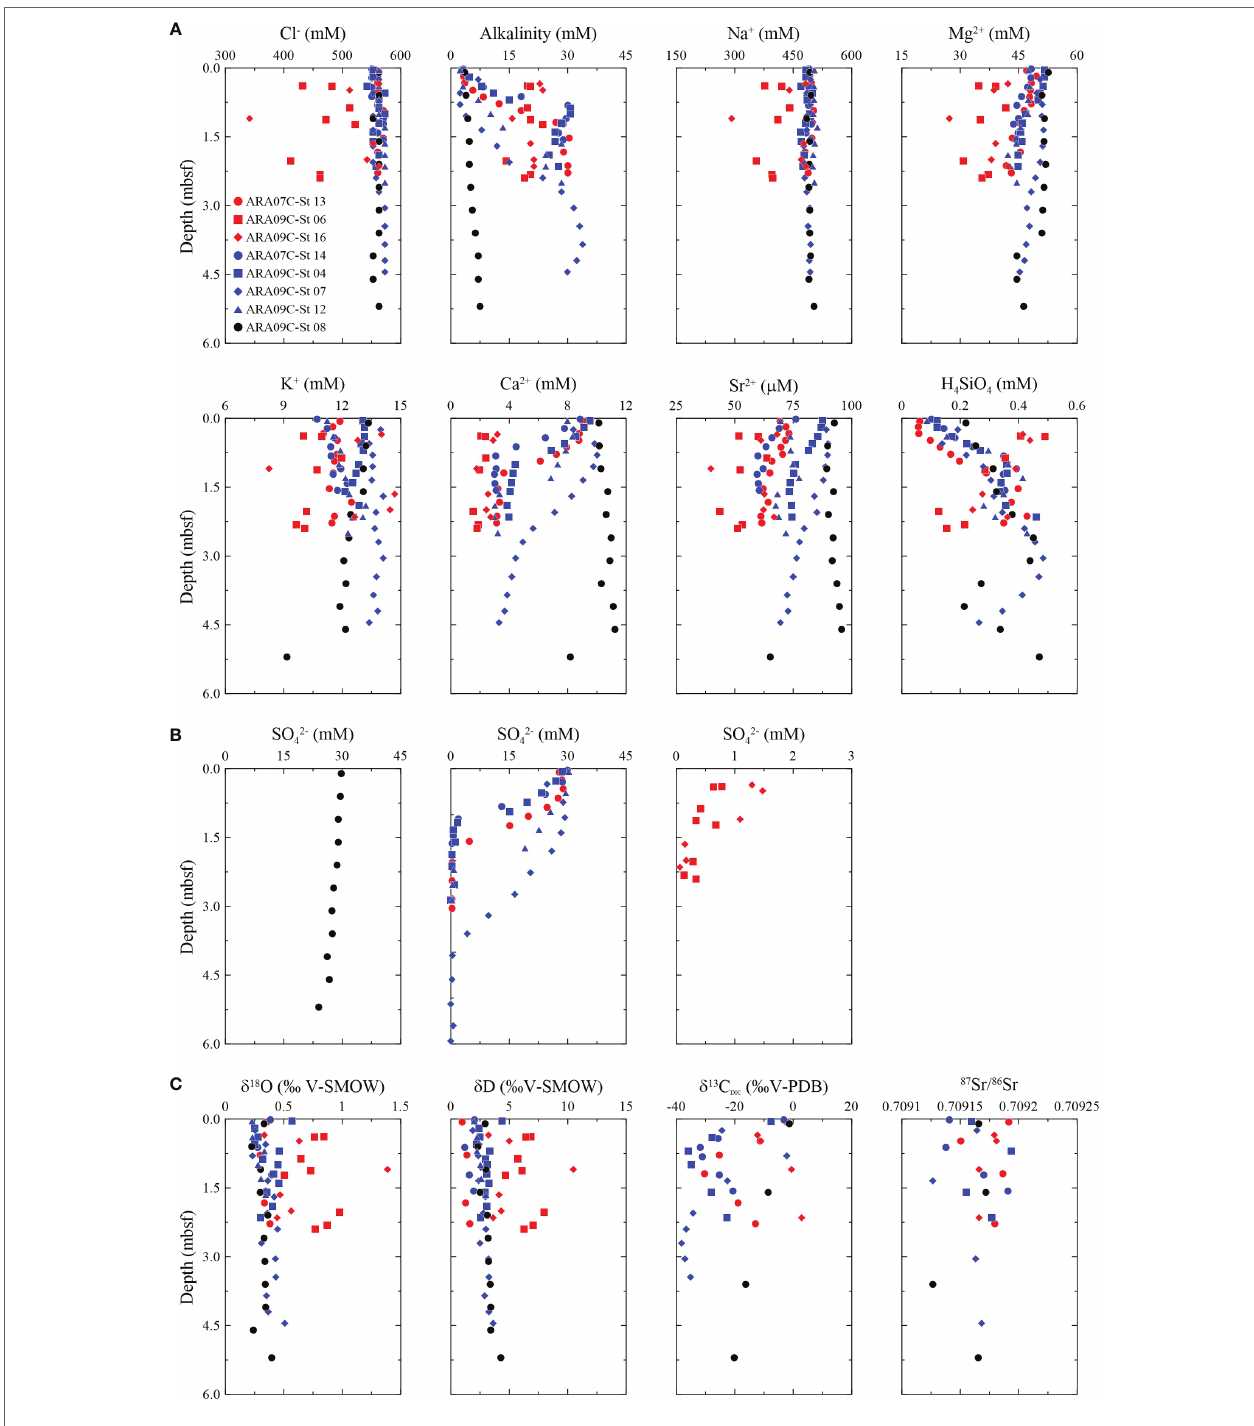
FIGURE 3 | (A) Downcore profiles of Cl - , alkalinity, Na + , Mg 2+ , K + , Ca 2+ , Sr 2+ , and H 4 SiO 4 in pore fluids from the ARAON Mounds. (B) Downcore profile of SO 42- in pore fluids from the reference site, non-GH bearing sites, and GH bearing sites in the ARAON Mounds. (C) Downcore profiles of δ 18 O, δ D, δ 13 C DIC , and 87 Sr/ 86 Sr in pore fluids from the ARAON Mounds. Black color site: reference site without GHs and MDCAs, blue color sites: observation of MDACs, and red color sites: observation of GHs and